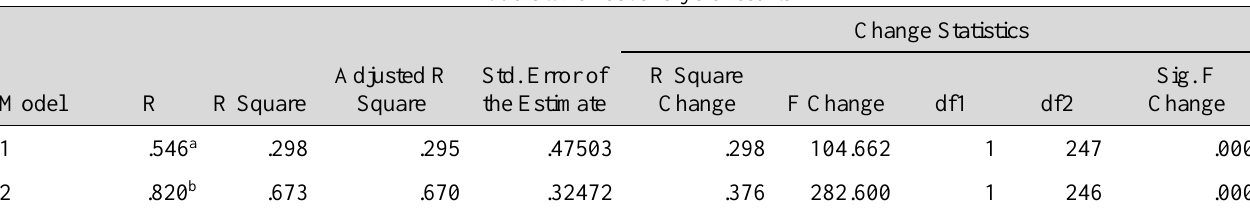
Moderator effect analysis